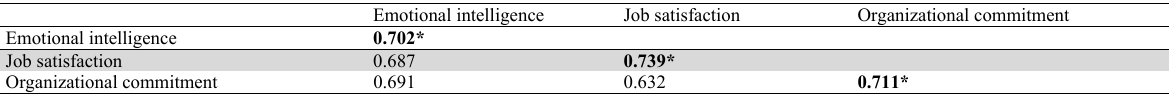
Correlation Matrix